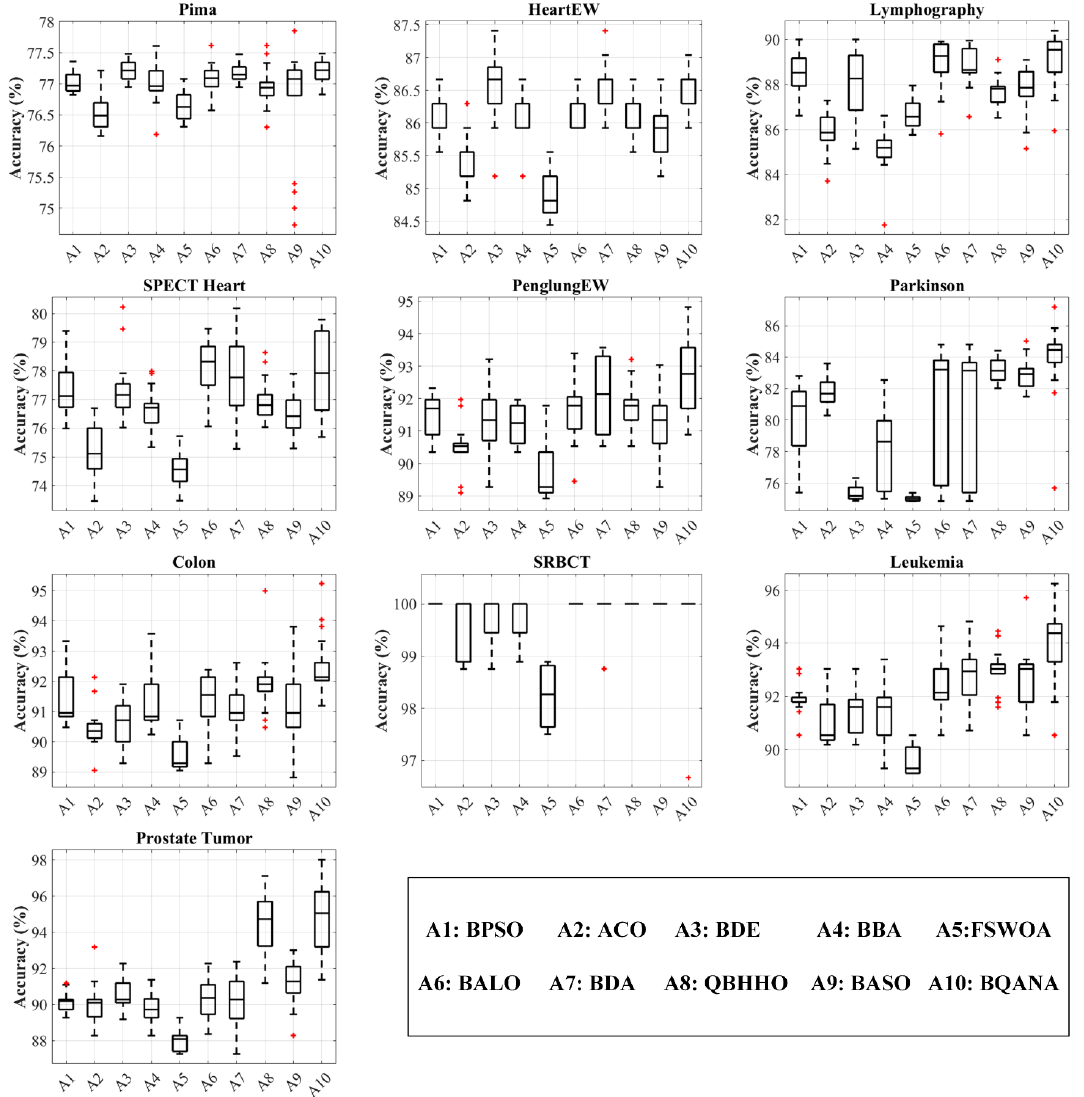
Figure 8. Boxplot of accuracy rate obtained by BQANA and comparative algorithms. Table 7. The Friedman test for the fitness obtained by each algorithm. Datasets